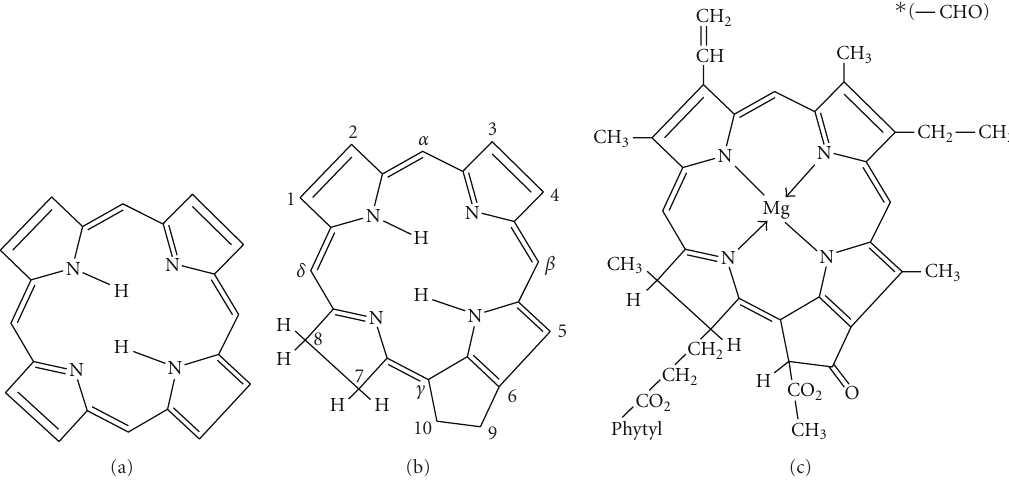
Figure 1: Chemical structures of chlorophyll and its constituents, extracted from [2]. (a) porphyrin macrocycle. (b) phorbin. (c) chlorophyll a , chlorophyll b is a variant with the methyl group in position 3 being replaced by a formyl group.